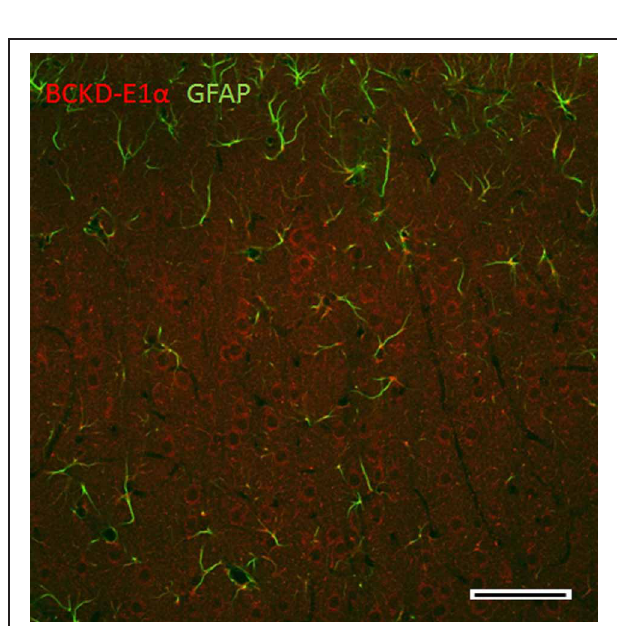
FIGURE 8 | Immunolocalization of BCKDC in the cerebral cortex. BCKDC is clearly expressed in the perinuclear regions of neurons in the pyramidal cell bodies. GFAP immunoreactivity is observed in astrocytic processes primarily in the apical surface. Scale bars: 100 μ m.